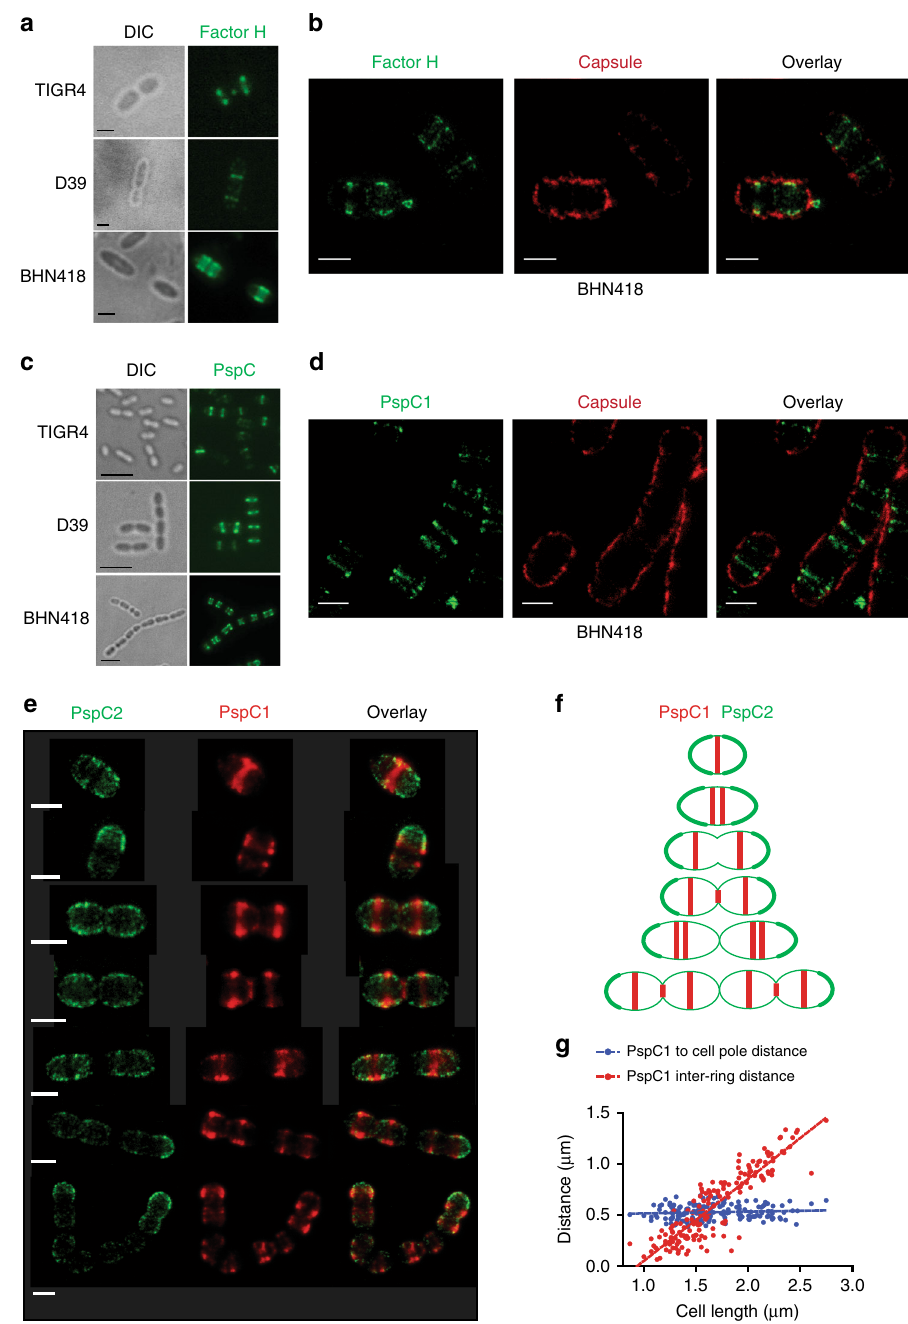
Fig. 3 Factor H (FH) recruitment by encapsulated pneumococci occurs at division sites where FH binding proteins are localized. PspC1 and PspC2 localize differently on the pneumococcal cell. a Representative immuno fl uorescence images of distinct localization of FH on strains TIGR4, D39, and BHN418. After incubation with pure FH, bacteria were stained with goat anti-FH antibody and FITC-labeled secondary antibody (green). b Super-resolution STED microscopy images of FH (stained green) and capsule (stained red) on strain BHN418. a , b Scale bar = 1 µ m. c Representative immuno fl uorescence images of PspC localization on strains TIGR4, D39, and BHN418. PspC was detected with mouse anti-PspC antiserum (D39) followed by anti-mouse Alexa fl uor 488 (green) secondary antibody. Scale bar = 5 µ m. d Super-resolution STED microscopy images of PspC1 (green) and the capsule (red) on strain BHN418. e Super-resolution STED microscopy images of different growth phases of strain BHN418 showing the distribution patterns for PspC1 (red) and PspC2 (green) during cell division and cell growth. d – f Scale bar = 1 µ m. f Schematic representation of the PspC1 and PspC2 distribution during different stages of cell division and cell growth. g The distances between PspC1 rings, and between PspC1 rings and the closest pole in BHN418 ( n = 166) are shown. Linear fi tting curve is shown in the